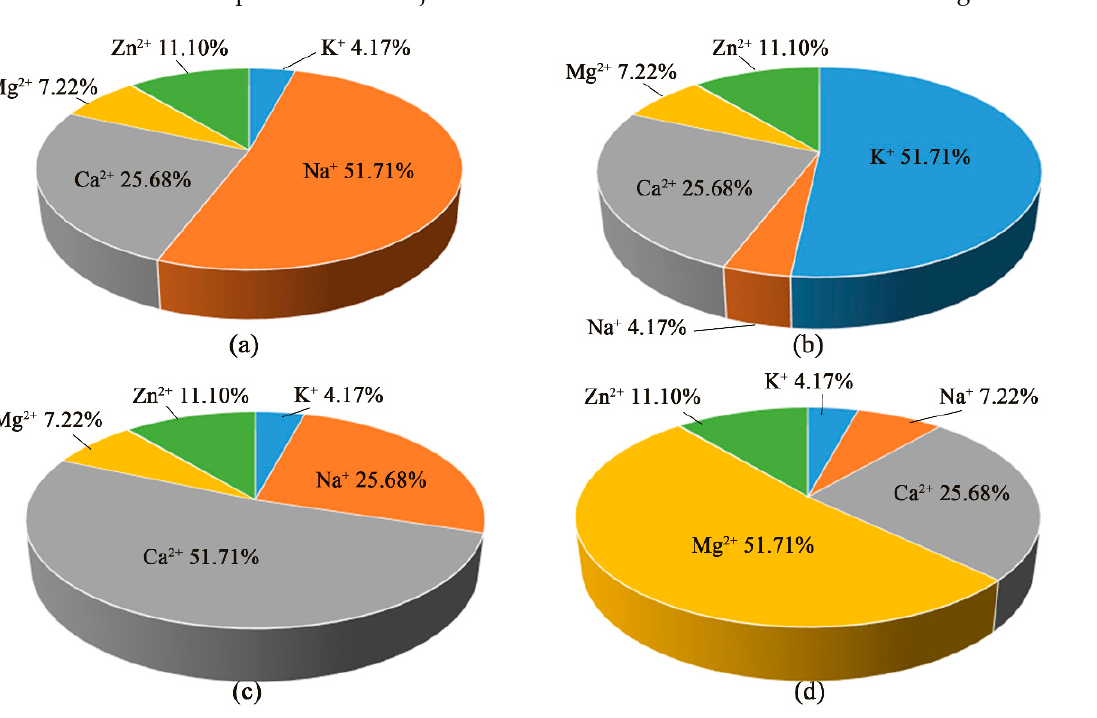
Figure 3. Simulation schemes for different chemical compositions of injected water. ( a )—Basic scheme; ( b )—Scheme 7; ( c )—Scheme 8; ( d )—Scheme 9. scheme; ( b )—Scheme 7 ; ( c )—Scheme 8; ( d )—Scheme